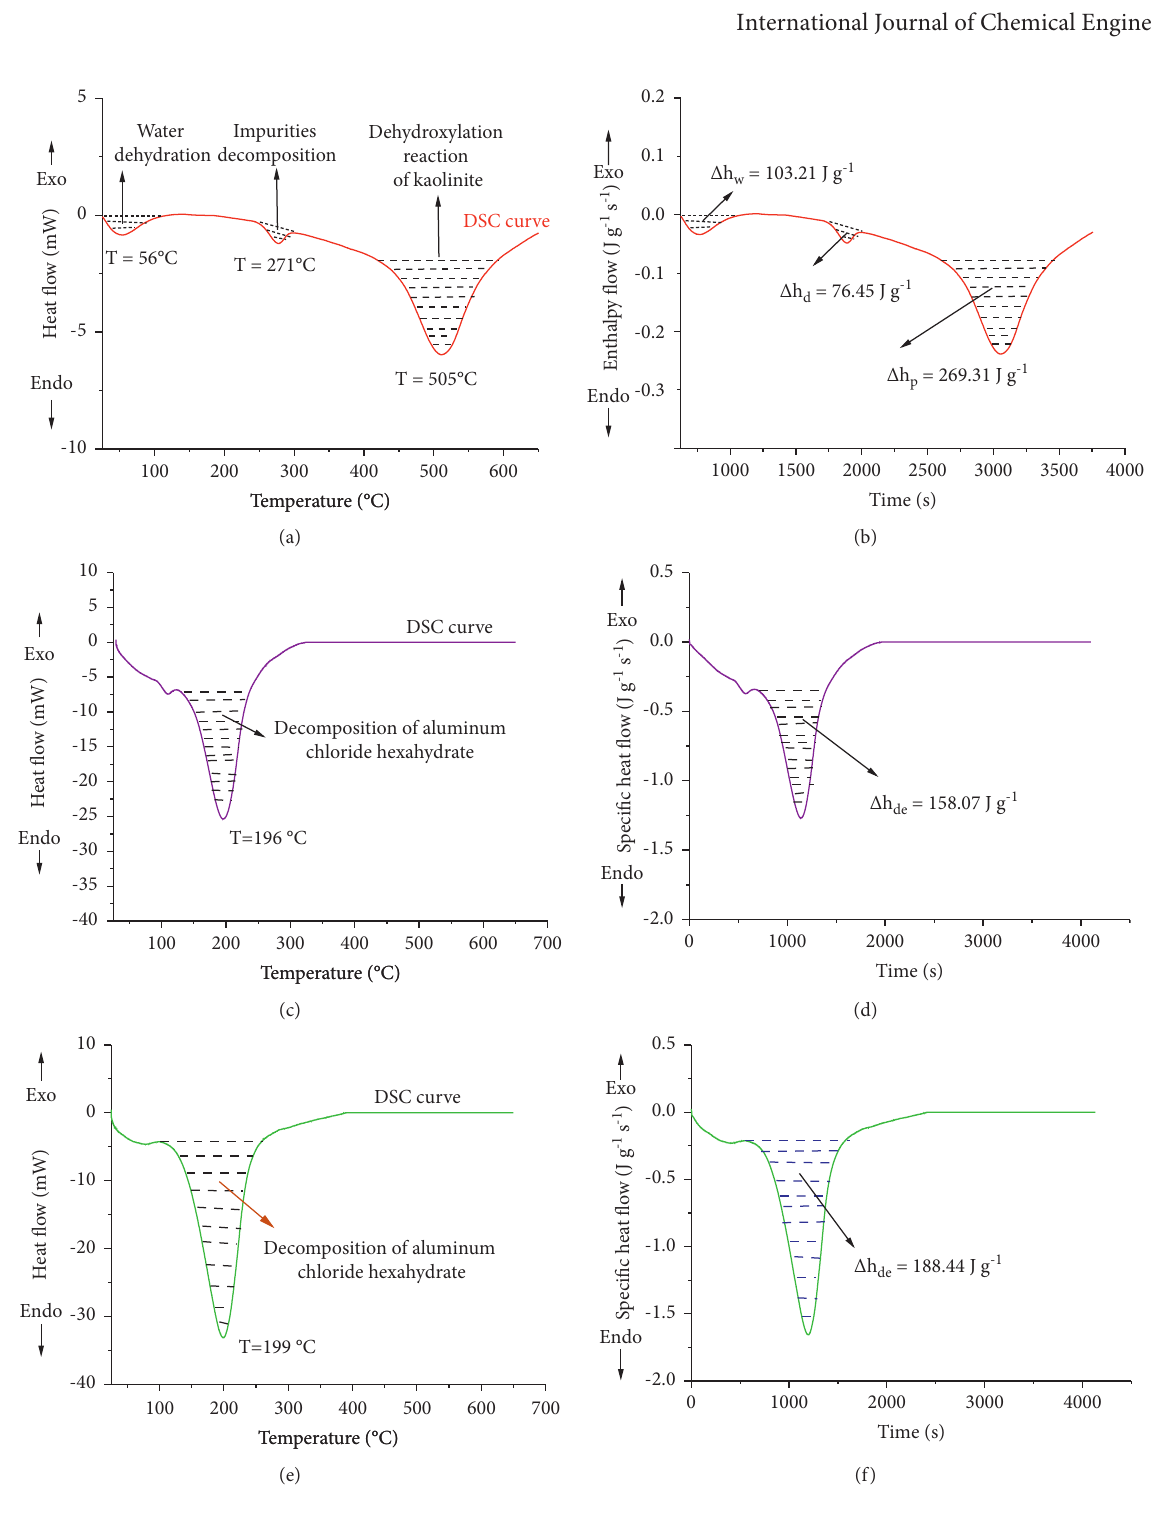
Figure 3: DSC curves of (a) kaolinite, (b) specific enthalpy of kaolinite, (c) extracted aluminum at 700 ° C, 180min, and 106 μ m, (d) specific enthalpy of extracted aluminum at 700 ° C, 180min, and 106 μ m, (e) standard aluminum chloride hexahydrate, and (f) specific enthalpy of standard aluminum chloride